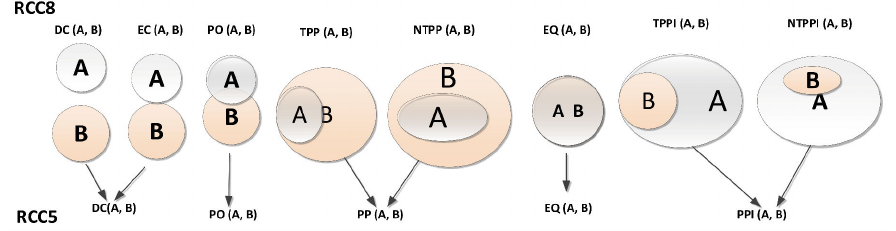
Figure 1. Illustration of RCC5 and RCC8 set of topological